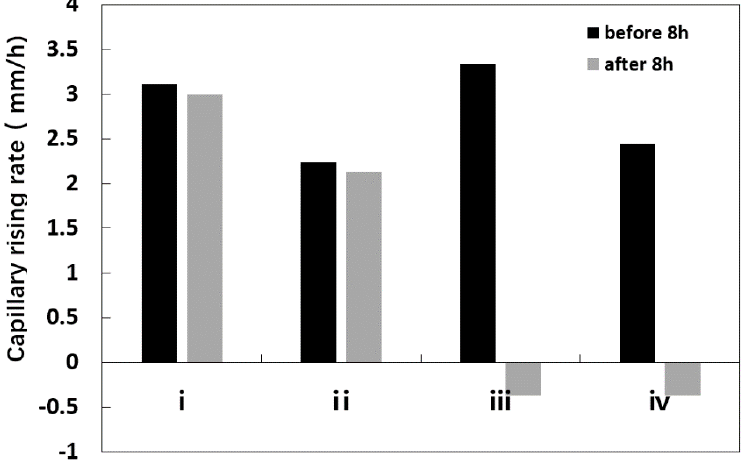
Figure 10. Capillary rising-rate of salt solution at different temperatures and concentrations.